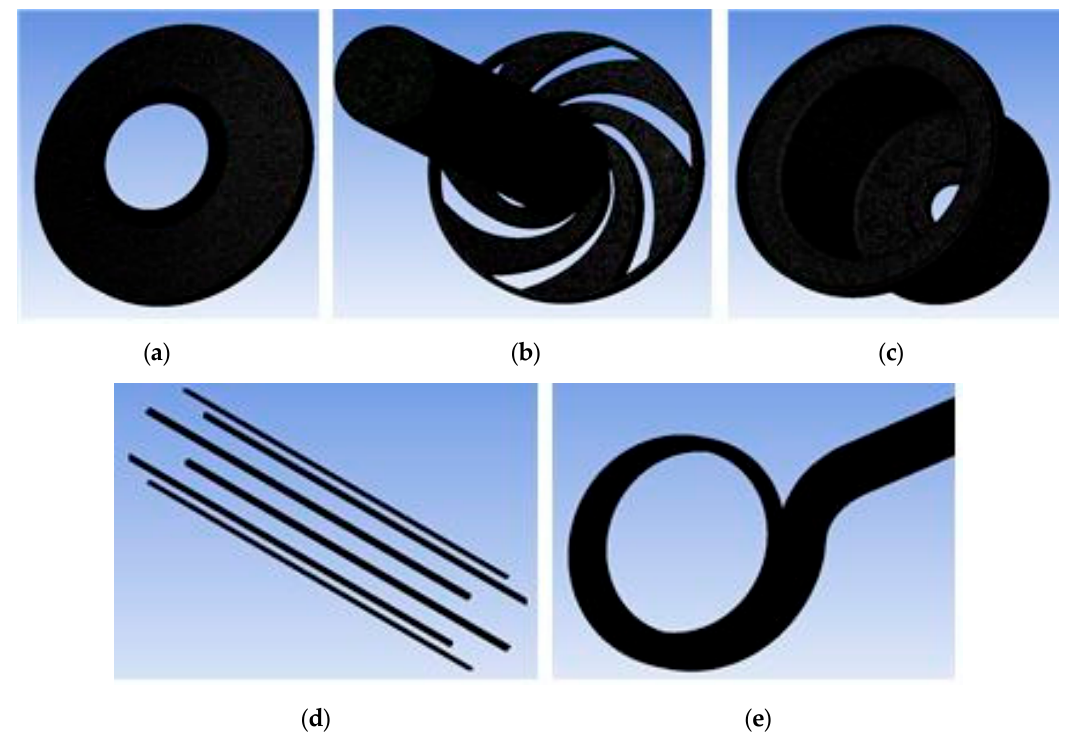
Figure 5. Meshes created for the CFD analysis of the pump model with Type B balancing holes.